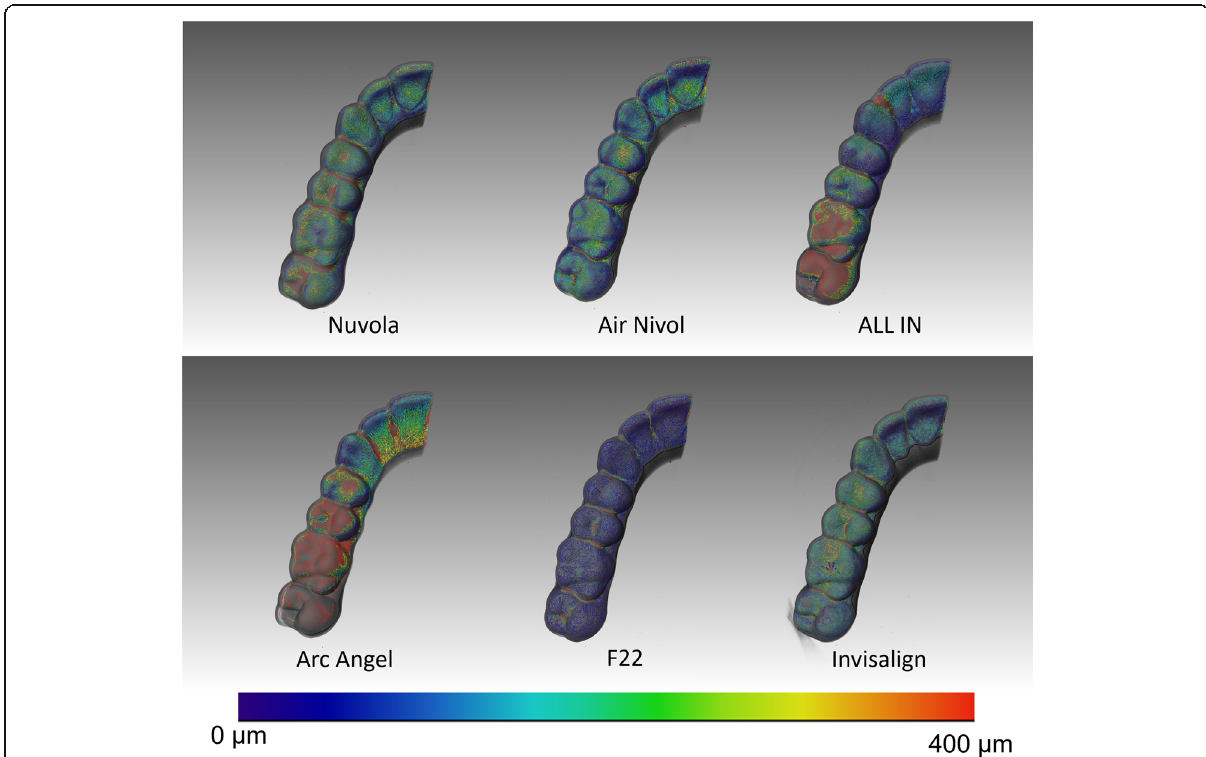
Fig. 6 Representative colourimetric skeleton with corresponding map of the distances measured for the six aligners from occlusal view